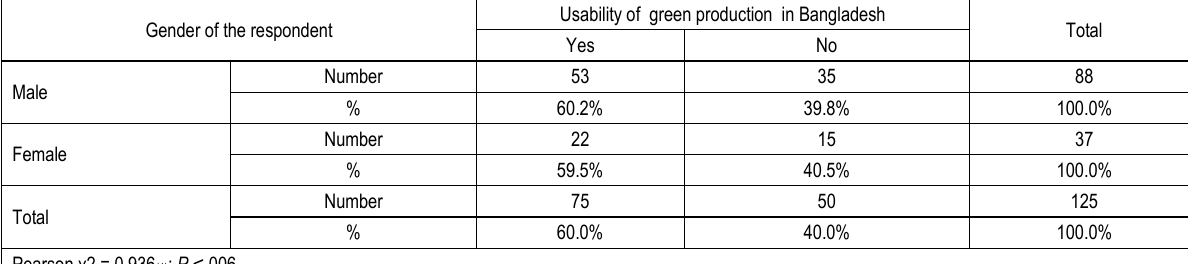
Table 1. Relationship between the respondents of both genders and usability of green production. Gender of the respondent